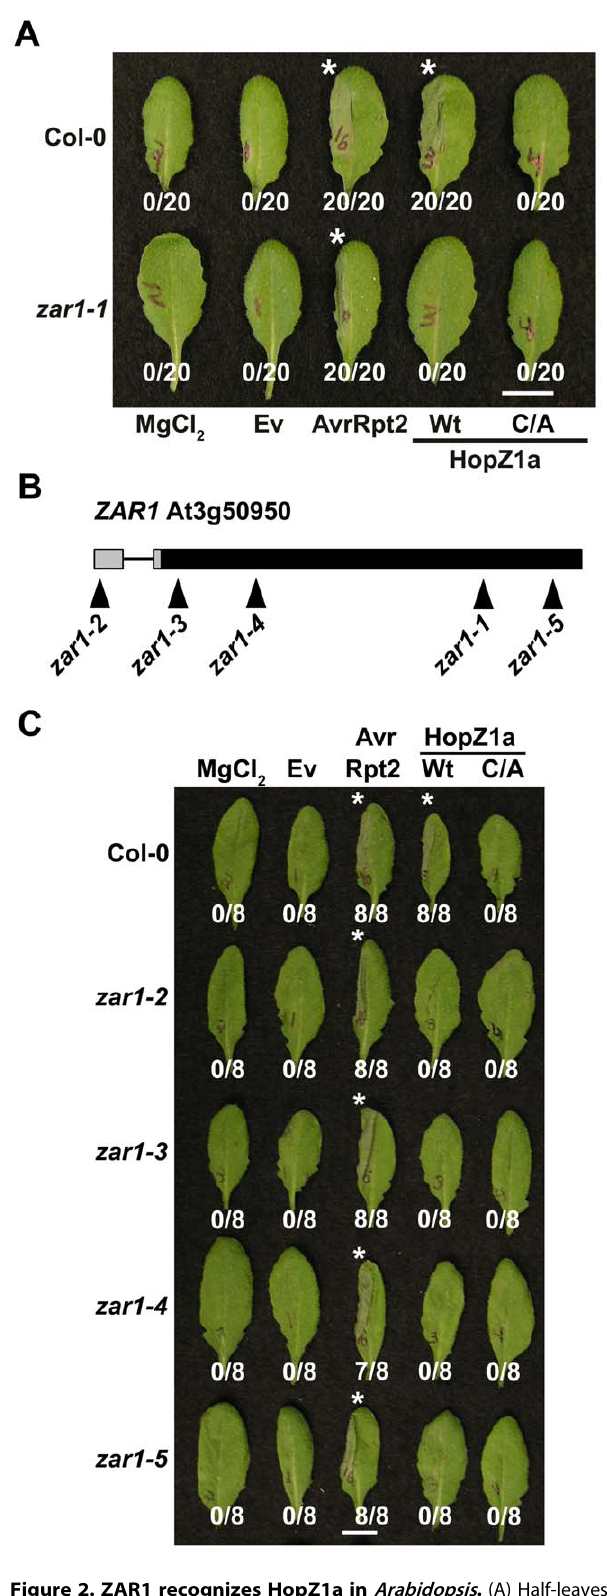
Figure 2. ZAR1 recognizes HopZ1a in Arabidopsis . (A) Half-leaves of Arabidopsis Col-0 or zar1-1 plants were infiltrated with 10 mM MgCl 2 or with Pto DC3000 expressing the empty vector (Ev), AvrRpt2, or HopZ1a or HopZ1a C216A (C/A) with a C-terminal HA tag under its endogenous promoter. C216 of HopZ1a is part of the